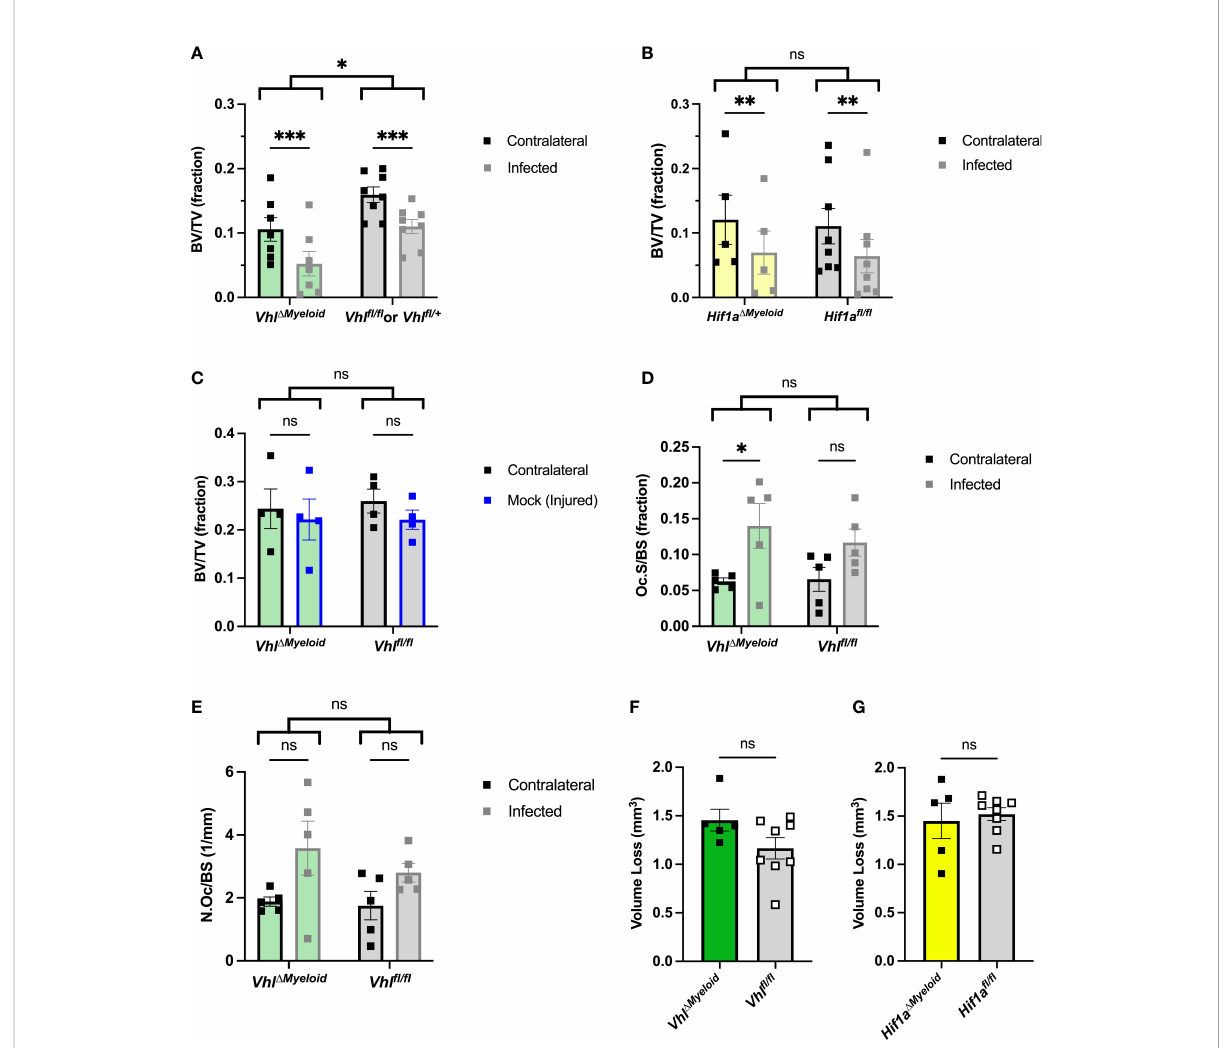
FIGURE 5 Conditional knockout of Vhl in myeloid cells slightly decreases trabecular bone volume during S. aureus osteomyeltis. (A) Trabecular bone volume per total volume (BV/TV) in Vhl D Myeloid mice and Cre-negative littermate Vhl fl / fl or Vhl fl /+ control mice ( n =7-8, male) at post-infection day 14 was measured in the distal metaphysis of infected and contralateral femurs. The differences between the groups were compared by two- way analysis of variance (ANOVA), which revealed that the genotypes (two bracketed groups) signi fi cantly differ. (B) Trabecular BV/TV in Hif1a D Myeloid mice and littermate Hif1a fl / fl control mice ( n =5-8, male) at post-infection day 14 was measured in the distal metaphysis of infected and contralateral femurs. The genotypes (two bracketed groups) did not signi fi cantly differ (ns) as compared by two-way ANOVA. (C) The BV/TV in Vhl D Myeloid mice and littermate Vhl fl / fl control mice ( n =4, male) at post-injury day 14 was measured in the trabecular bone of the distal metaphysis of mock-infected and contralateral femurs. Injury signi fi cantly reduced BV/TV compared to contralateral femurs ( p < 0.05, not depicted; ns by multiple comparisons within genotypes by two-way ANOVA with correction for multiple comparisons). The genotypes (bracketed groups) did not signi fi cantly differ as compared by two-way ANOVA. (D) Osteoclast surface per bone surface (Oc.S/BS) is expressed as a fraction from bone histomorphometry performed on trabecular bone in the distal metaphysis of infected and contralateral femurs for male Vhl D Myeloid mice ( n =5) and Cre-negative littermate Vhl fl / fl mice ( n =5). The measurements for the infected and contralateral femurs are statistically different ( p < 0.01), and the genotypes do not signi fi cantly differ by two ‐ way ANOVA. With correction for multiple comparisons, the measurements of the infected and contralateral limbs do not reach signi fi cance for the Cre-negative littermate but do for the Vhl D Myeloid mice. (E) Parallel analysis of sections analyzed in (D) were performed to measure the number of osteoclasts per bone surface (N.Oc/BS). The measurements for the infected and contralateral limbs are statistically different ( p < 0.05), and the genotypes do not signi fi cantly differ by two ‐ way ANOVA. With correction for multiple comparisons, the measurements of the infected and contralateral limbs do not reach signi fi cance. (F, G) The volume of cortical bone loss in male Vhl D Myeloid (F) or Hif1a D Myeloid (G) mice and respective littermate controls at post-infection day 14 was assessed by microcomputed tomography ( n =5-8). * p < 0.05, ** p <0.01, *** p <0.001, and ns denotes difference did not meet the p < 0.05 standard for signi fi cance as determined by two ‐ way ANOVA with correction for multiple comparisons of the infected (or mock infected) and contralateral limbs for each genotype individually (A-D, G) , or as determined by unpaired, two-tailed Student ’ s t -test (E, F) . P -values between bracketed groups of data refer to two-way ANOVA assessment of genotype as a variable without multiple comparisons by laterality (infected vs. contralateral) of femur (A-D, G) . Error bars represent